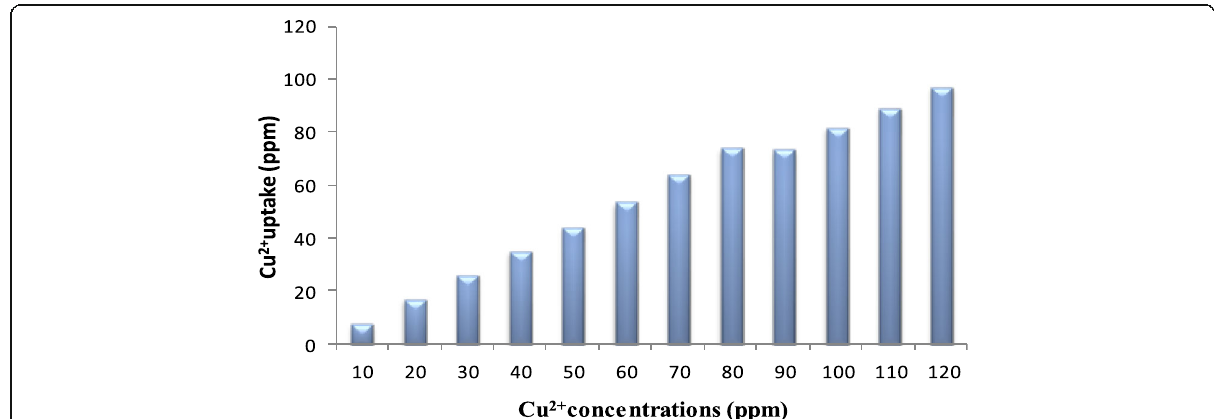
Fig. 1 Effect of Cu 2+ concentration on Cu 2+ uptake by Aspergillus tamarii NRC 3 biomass (pH 5; temp., 30 °C; rpm, 150; biomass dosage,5 g; contact-time, 1 h)